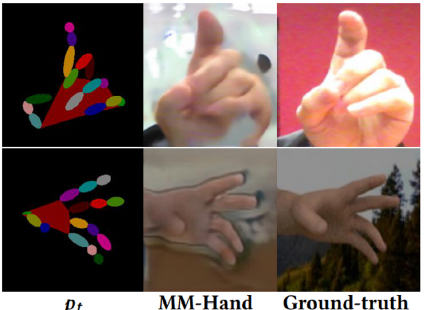
Figure 5. Qualitative results under MM-Hand model originally reported in [34]. Synthesized hand images using MM-Hand on two datasets, STB and RHP. From top to bottom: the STB dataset and the RHP